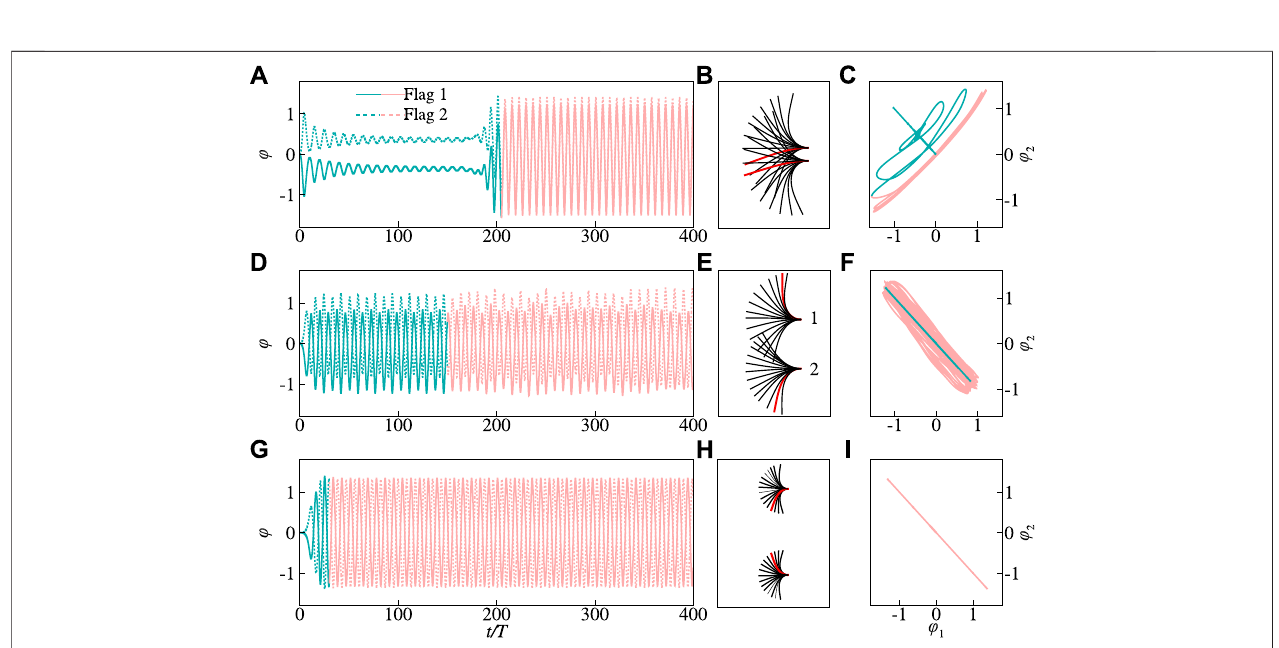
FIGURE 3 | Time history of the instantaneous fl apping angle φ on the left (A,D,G) , the superimposed views of the fl ags on the middle (B,E,H) , and the phase trajectories in φ 1 − φ 2 planes on the right (C,F,I) for distinct modes in the side-by-side inverted fl ags, i.e., in-phase mode with H =0.2 (A,B,C) , quasi out-of-phase mode with H =0.9 (D,E,F) andout-of-phasemodewith H =3 (G,H,I) .Theothergoverningparametersareasfollows:Re=200, M =2.9, K =0.3and S =1,000.Flag1andFlag2 represent the upper and lower fl ags, respectively. The red beams on the middle column represent the instantaneous position of the fl ags at a certain instant. The phase diagrams have been colored to represent time, with the curve being initially green and shifting to red as time advances.